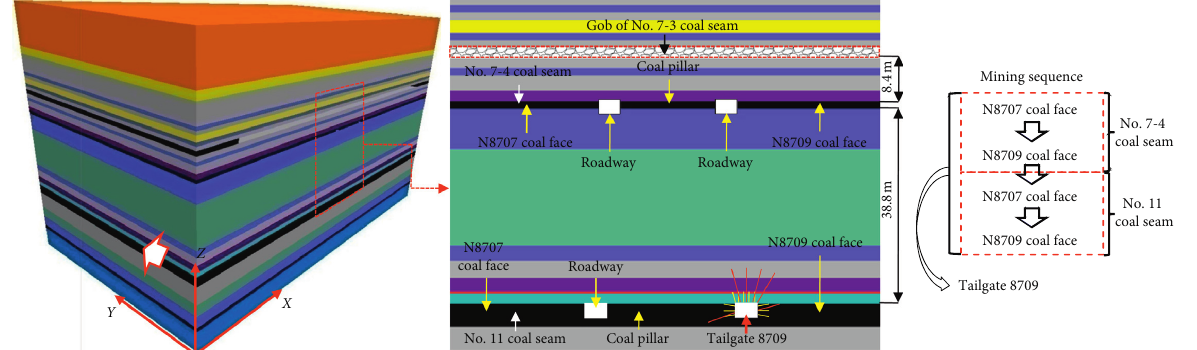
Figure 2: Numerical model and roadway